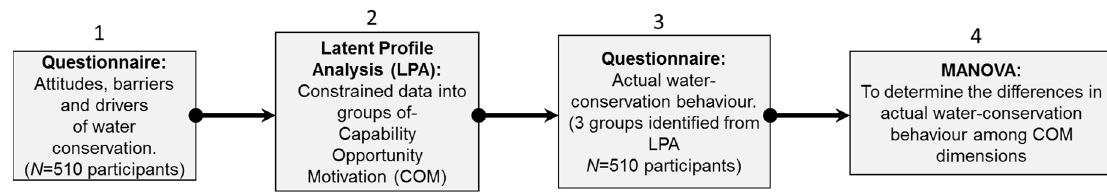
Figure 1. Flow diagram of data collection and processes.